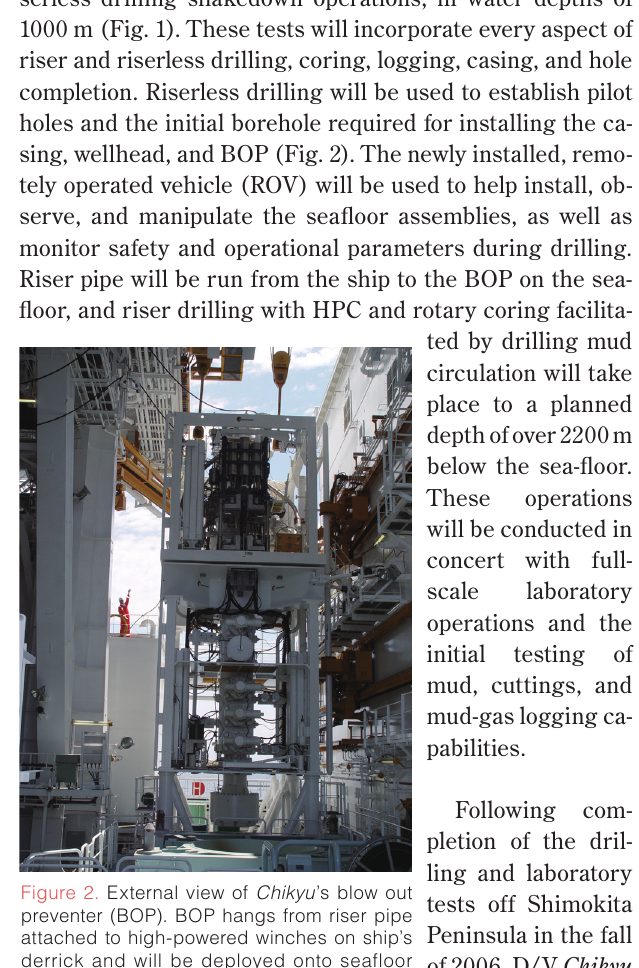
Figure 2. External view of Chikyu ’s blow out preventer (BOP). BOP hangs from riser pipe attached to high-powered winches on ship’s derrick and will be deployed onto seafloor through moonpool below drilling platform. Note person on left for scale.